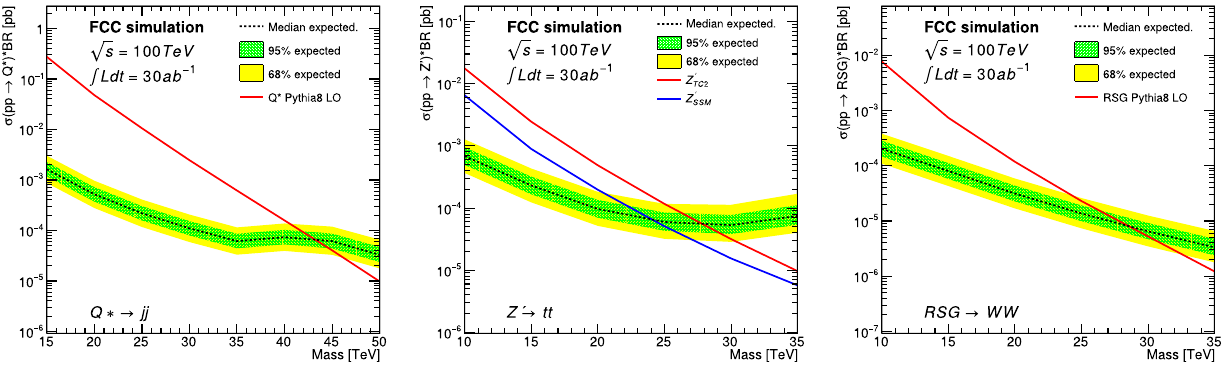
Fig. 15.6 Left(centre):Crosssectiontimesbranchingratio95%CLlimitsversusmass,fortheee + μμ ( ττ ) finalstates,comparedtotheexpectations of several Z (cid:3) models. Right: luminosity required for the 5 σ discovery of a SSM Z (cid:3) in the dilepton channel, versus the hypothetical resonance mass